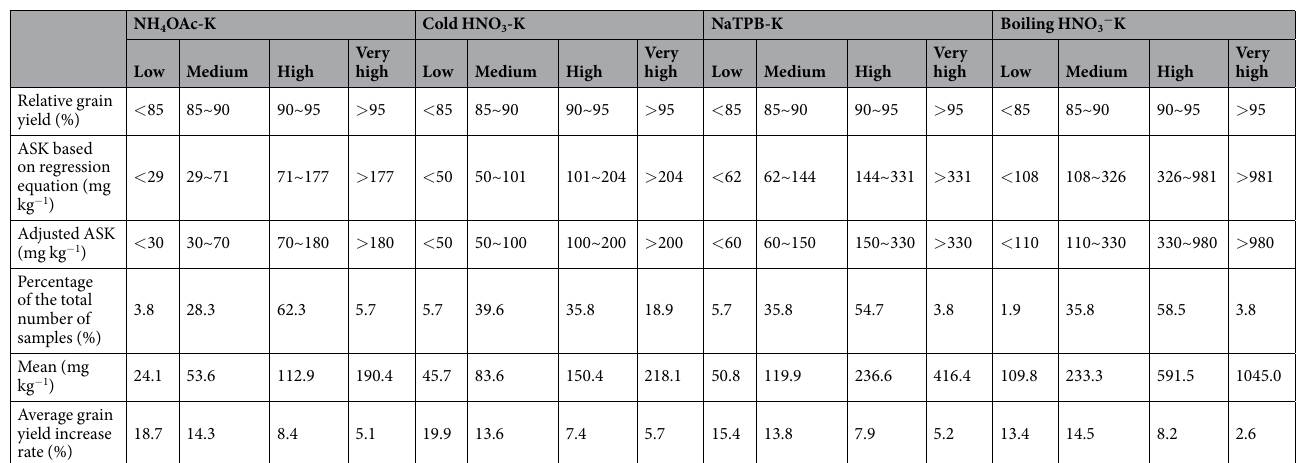
Table 2. Abundance and deficiency indices of available soil potassium (ASK) extracted with 1.0 mol L −